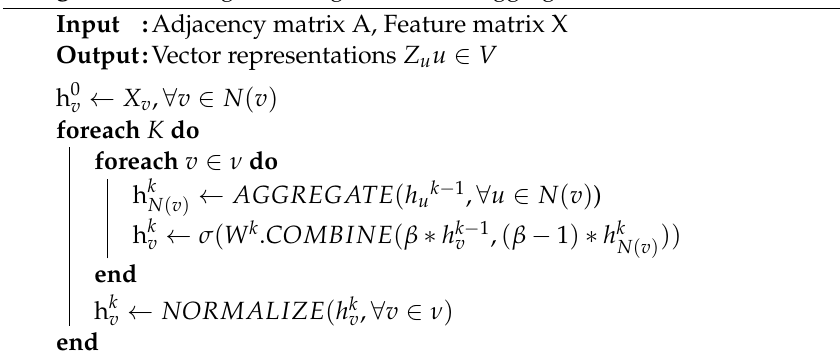
Algorithm 1: Weighted Neighbourhood Aggregation